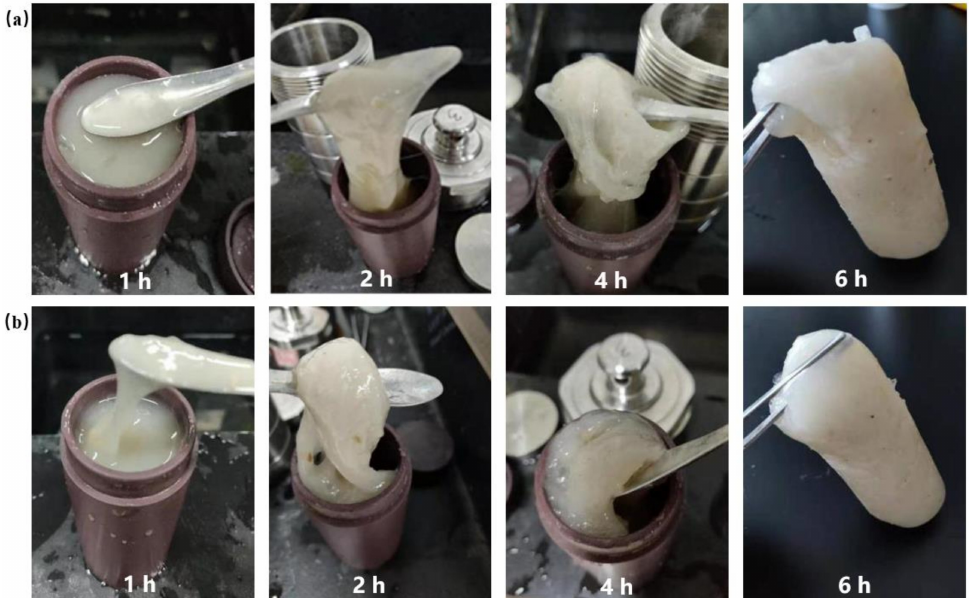
Figure 7. Gel morphology of high concentration initiator at different gelation times: ( a ) 0.3% initiator; ( b ) 0.5%